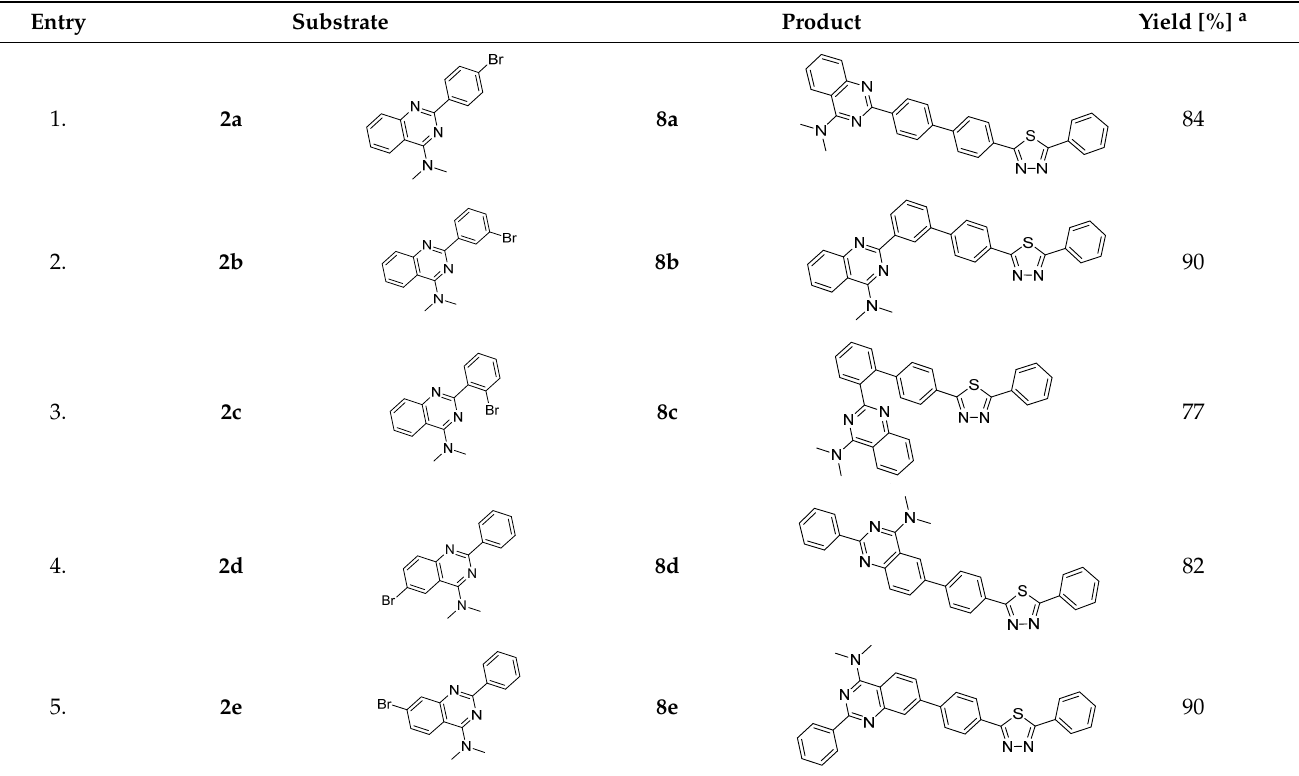
Table 2. Unsymmetrical quinazolinylphenyl-1,3,4-thiadiazole derivatives ( 8a – e ) synthesized via Suzuki cross-coupling reactions.